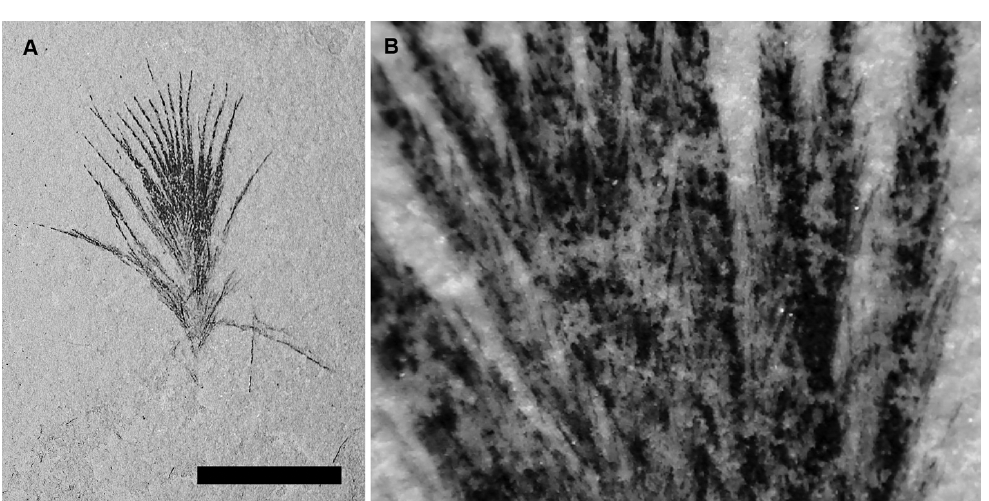
Fig. 3 – A: Semiplume CAV 0002-V. B: Detail of the barbs and barbules in the distal region of the feather. Scale Bar 5 mm in A, B not in scale.